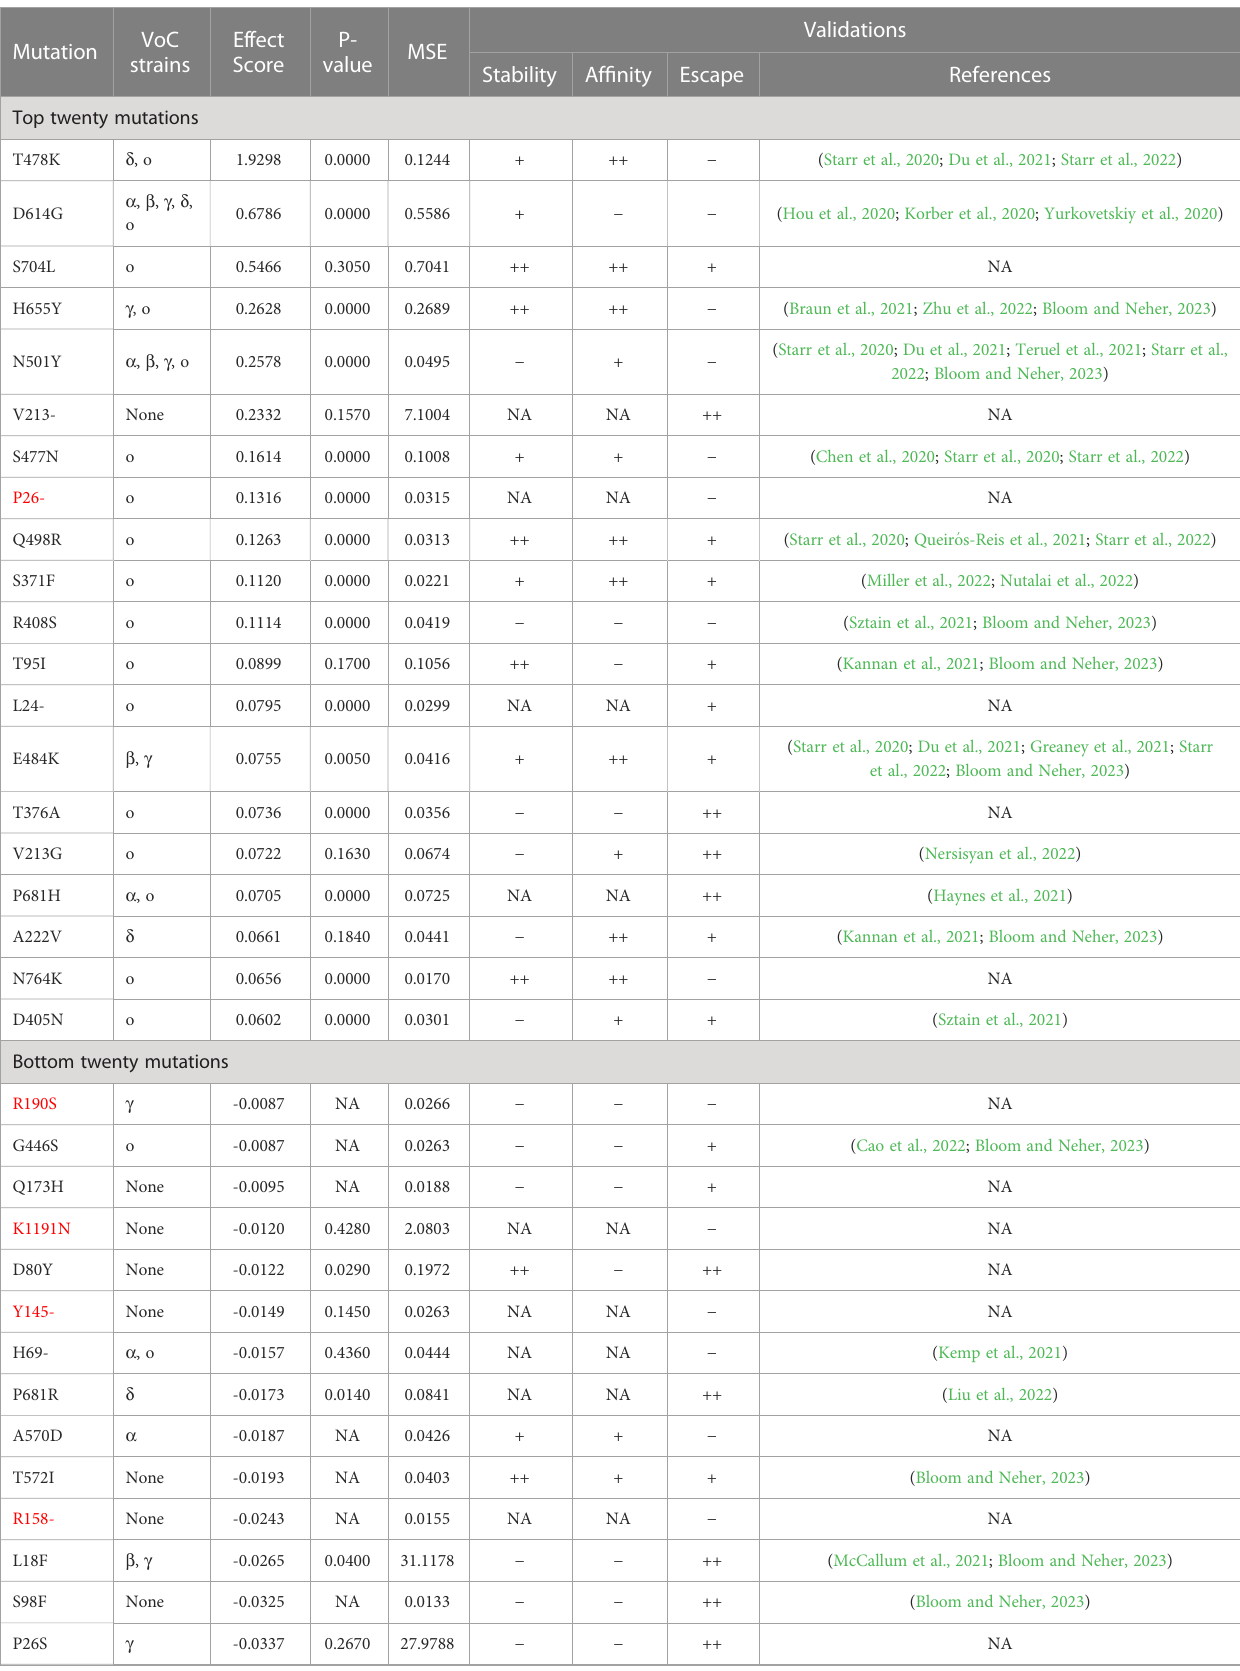
TABLE 1 Effect score of the top and bottom twenty mutations, with model metrics, effect validations, and supportive references.